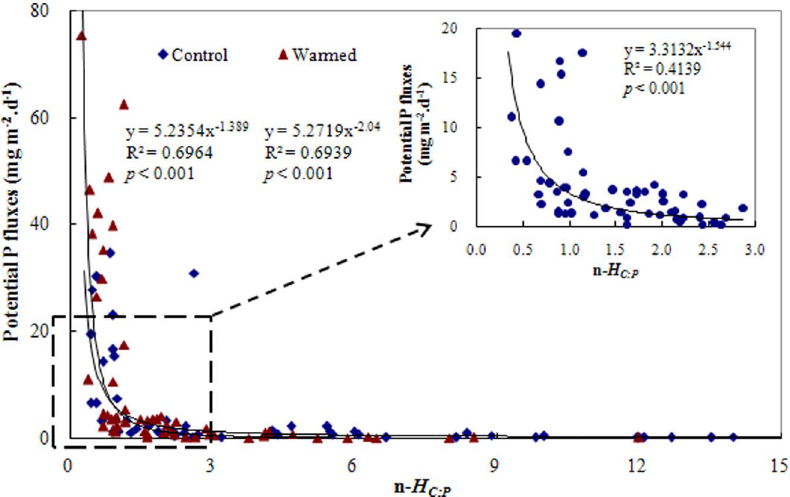
Figure 4. Relationship between potential phosphorus (P) flux and the specialized ability of stoichiometric homeostasis (n- H C:P ) as a molar ratio of soil highly labial organic carbon (HLOC) to dissolved reactive phosphorus (DRP) in each of the wetland soil columns. Control and Warmed represent treatments of ambient temperature and ambient temperature + 5 u C, respectively. The data for P flux and n- H C:P less than 20 mg m 2 2 d 2 1 and 3.0, respectively, are plotted in the figure inset. C:P stoichiometric homeostasis and associated variations in n- H C:P